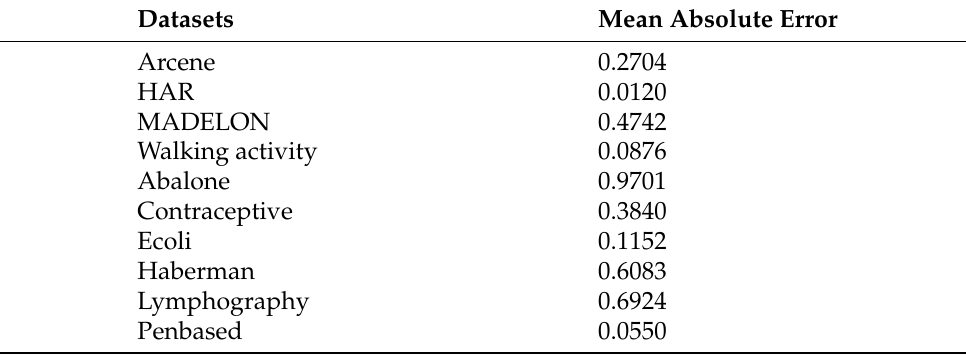
Table 10. Mean absolute error of deep learning classification